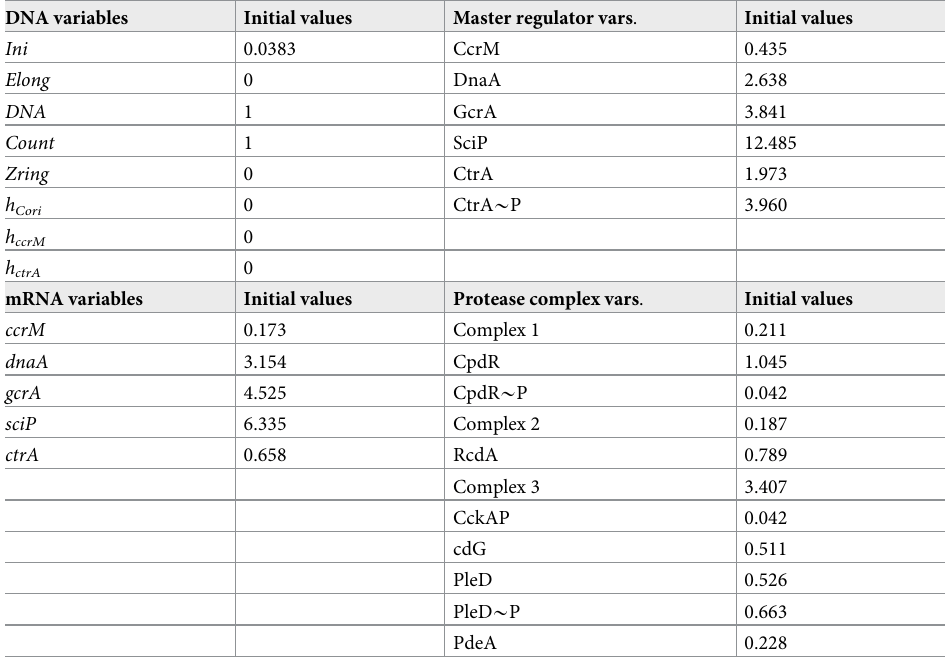
Table 6. Initial values of model